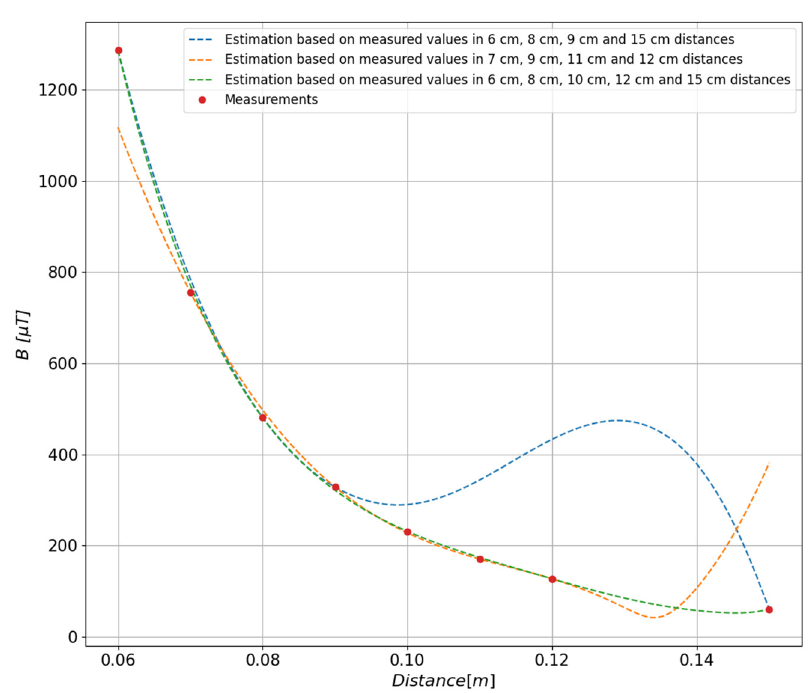
Figure 10. Comparison of three approximating polynomials determined on the basis of different training vectors.